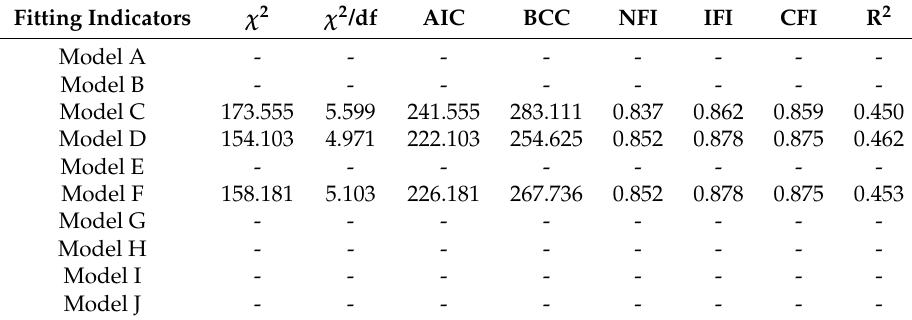
Table 5. Comparison of fitting results among models. AIC—Akaike information criterion; BCC— Browne–Cudeck criterion; NFI—normed fit index; IFI—incremental fit index; CFI—comparative fit index.